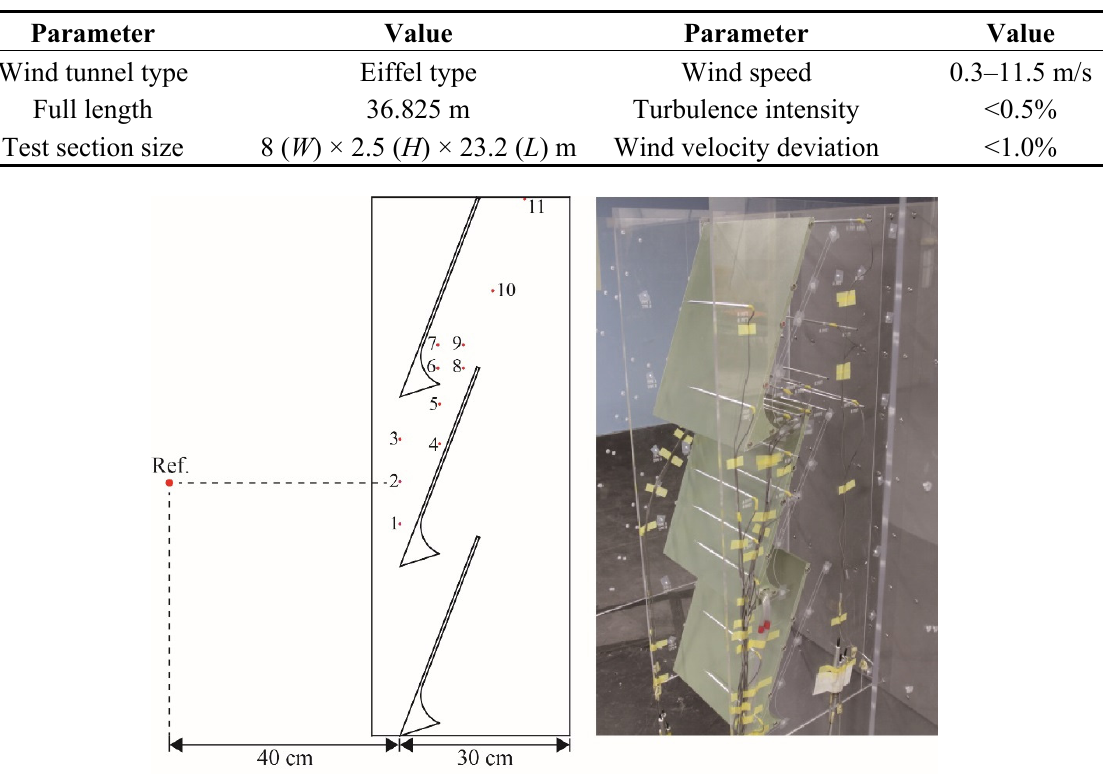
Figure 13. Scaled guide vane model. Table 3. Specifications of the boundary layer wind tunnel.